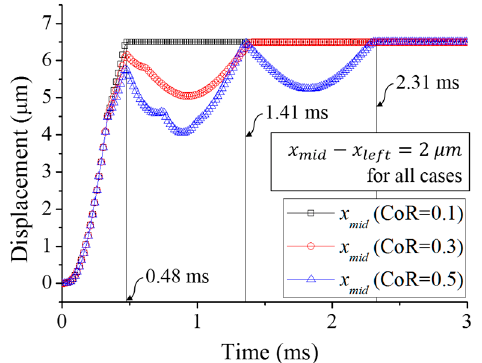
Figure 4. Analysed displacements of (cid:1876) (cid:3040)(cid:3036)(cid:3031) for different coefficients of restitutions (CoR). Black square, red circle, and blue triangle indicates cases of having CoR of 0.1, 0.3, and 0.5,